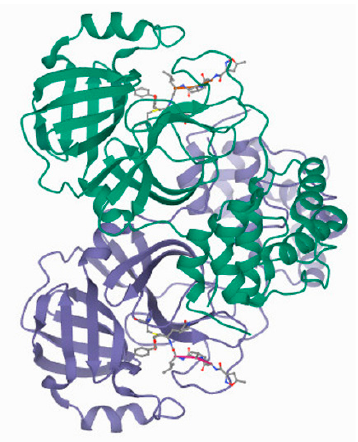
Figure 4. Crystal structure of SARS-CoV-2 3CL pro /M pro bound to its inhibitor named N3. Inhibitors are located at the two substrate binding sites. Two protomers, A and B, are presented in green and purple. Image obtained by Jin et al., 2020 [57], PDB entry: 6LU7.